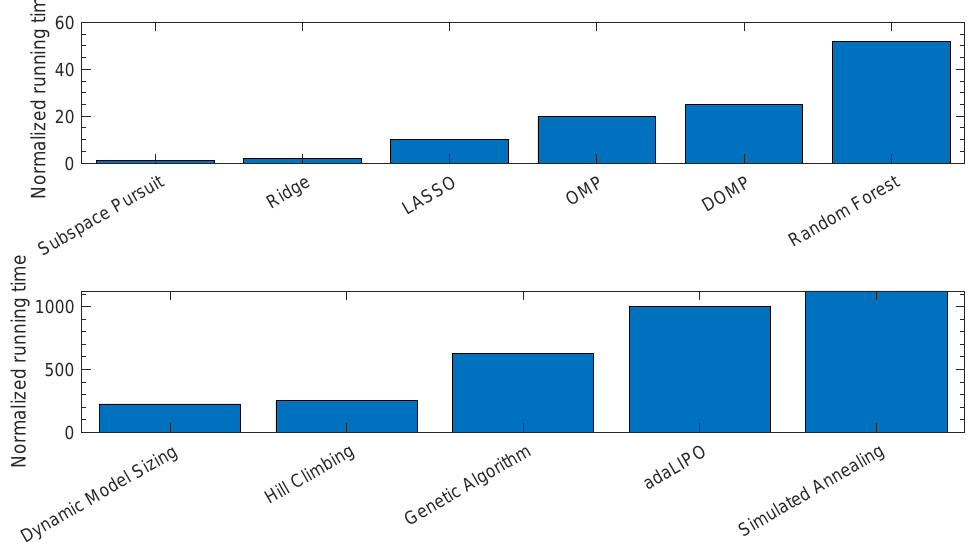
Figure 10. Normalized running time considering different feature selection